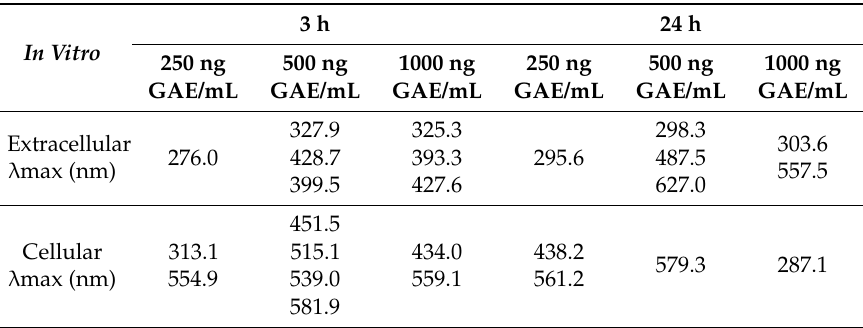
Table 2. Absorption maxima for the overlaid UV-Vis spectra subtractions of IPEC-1 cells’ extracellular medium and cellular matrix treated with AGP ( in vitro